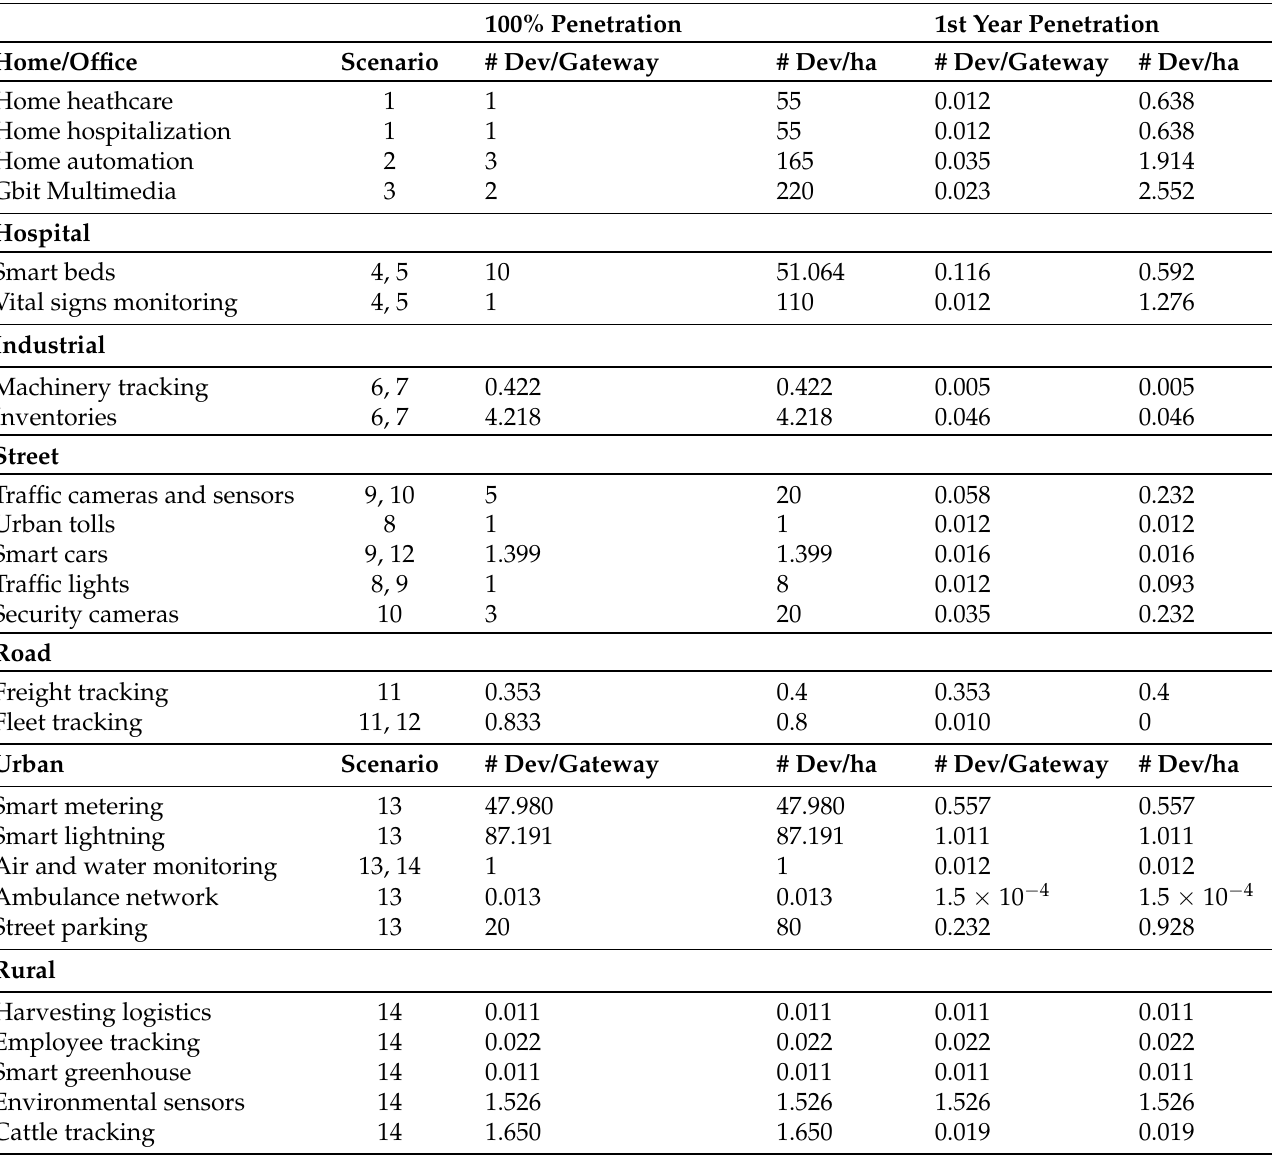
Table 2. IoT expected penetration per service (peak